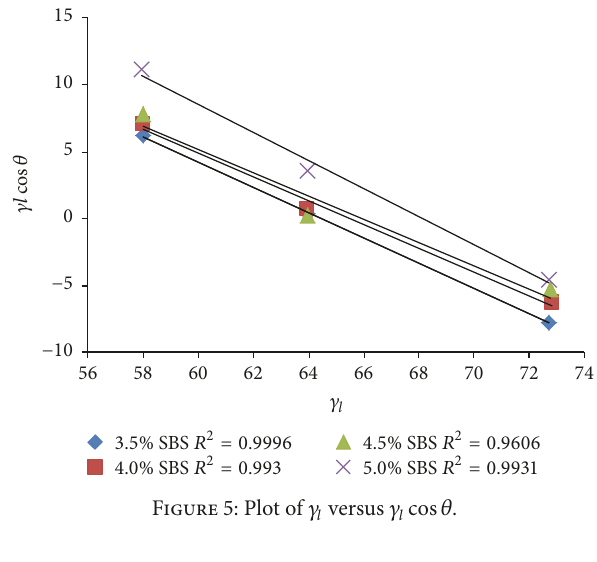
Figure 7: The cohesive work of SBS-modified asphalts prepared by different SBS